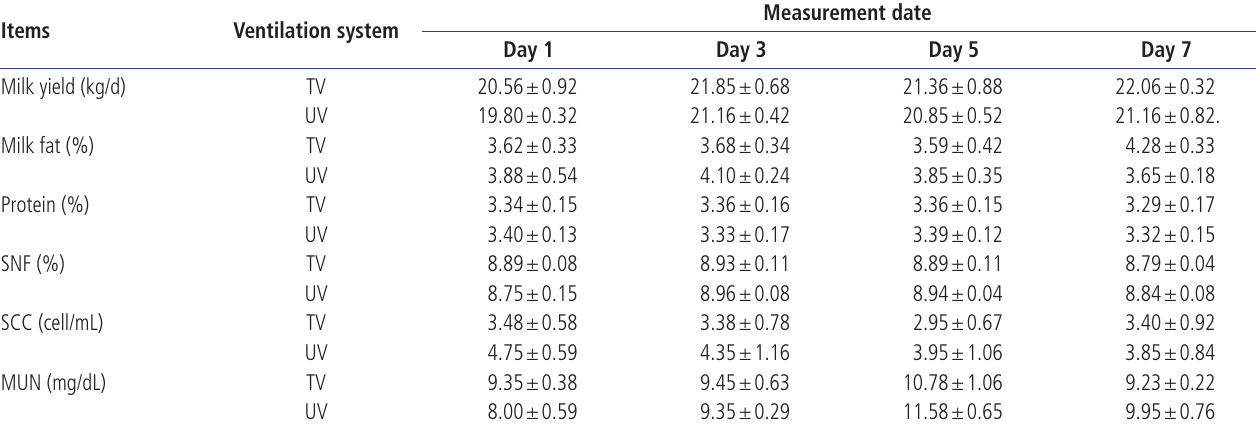
SNP, solids-not-fat; SCC, somatic cell count; MUN, milk urea nitrogen. 1) Data represent means±standard error of the mean of ten cows in three experimental periods in each ventilation system (n = 30; 10 cows×1 day×3 terms). 2) There were no significant differences between the unventilated (UV) condition and tunnel-ventilated (TV) system